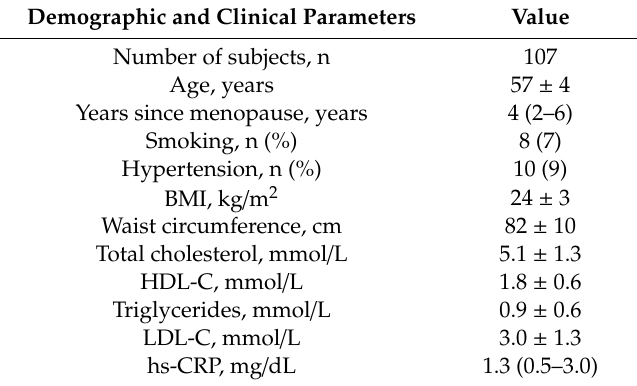
Table 1. Principal characteristics of the subjects.